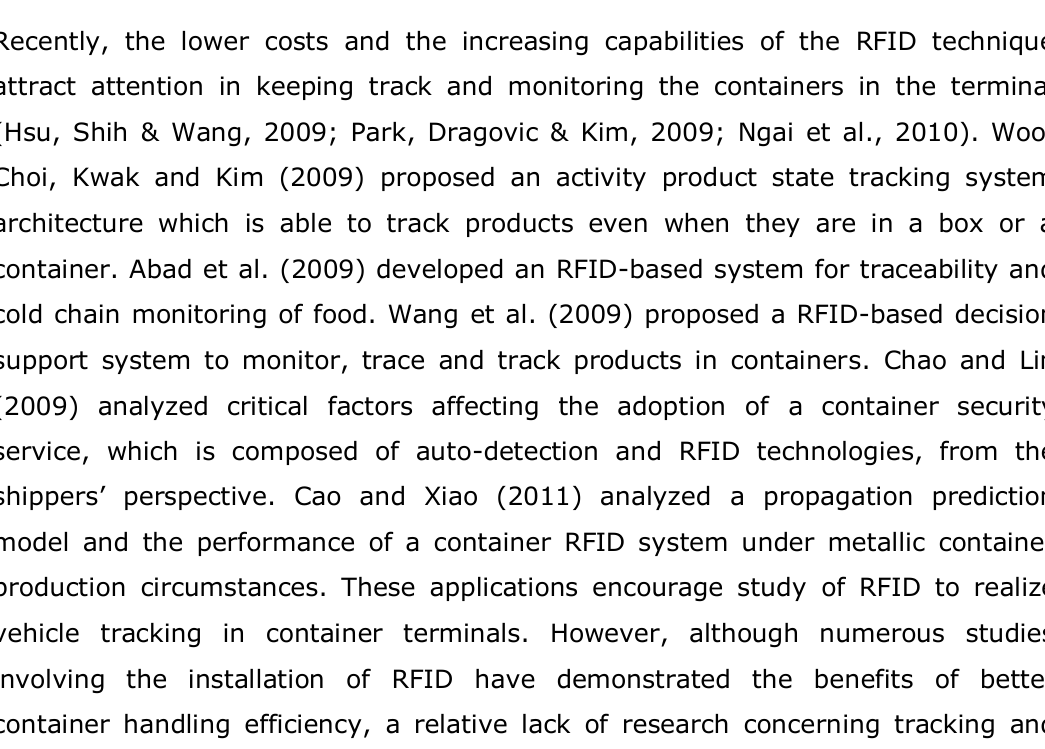
Figure 1. Basic Components of an RFID System (Kwok, Tsang & Cheung,